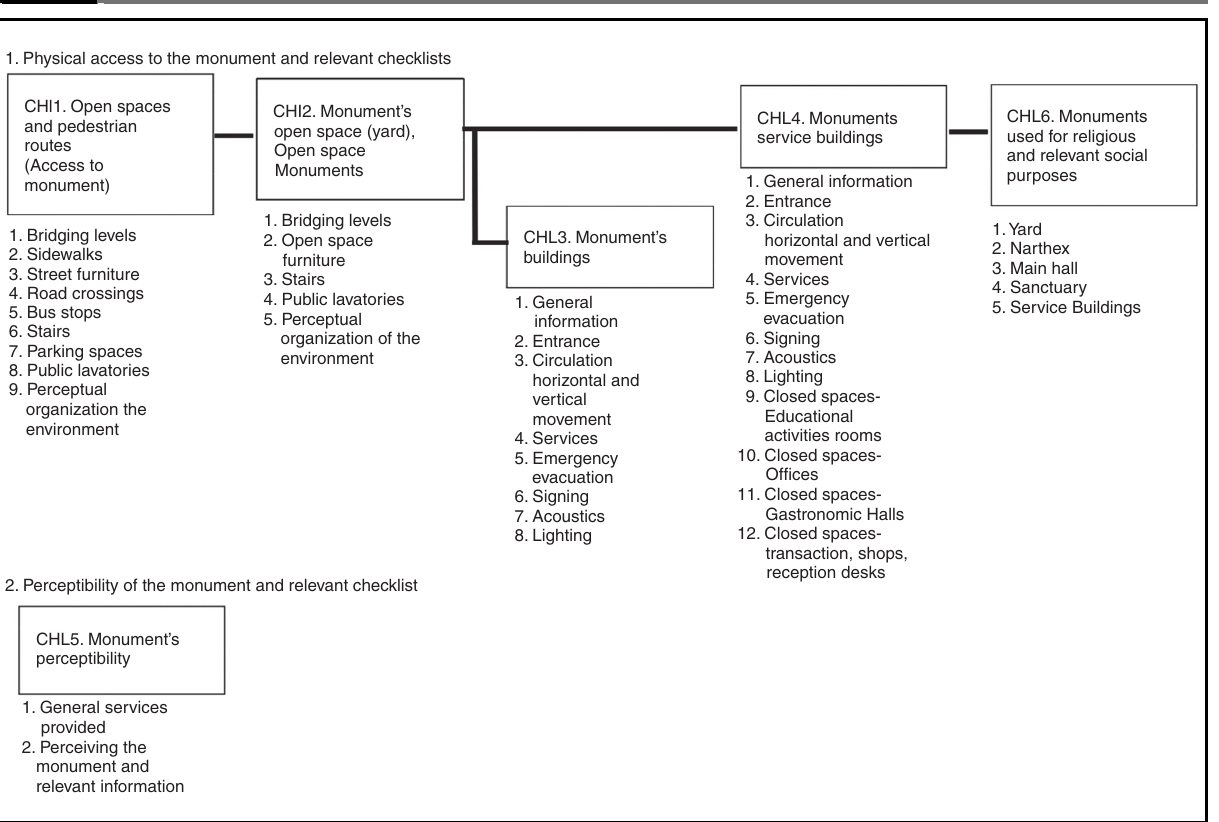
Figure 3 The checklists developed